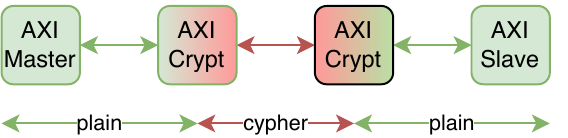
Figure 3. The proposed system is introduced between a master and slave. Plain text (green) is inserted into the bus by the master; the designed core encrypts it (red) and passes it to the end designed core, where it is decrypted and sent to the end